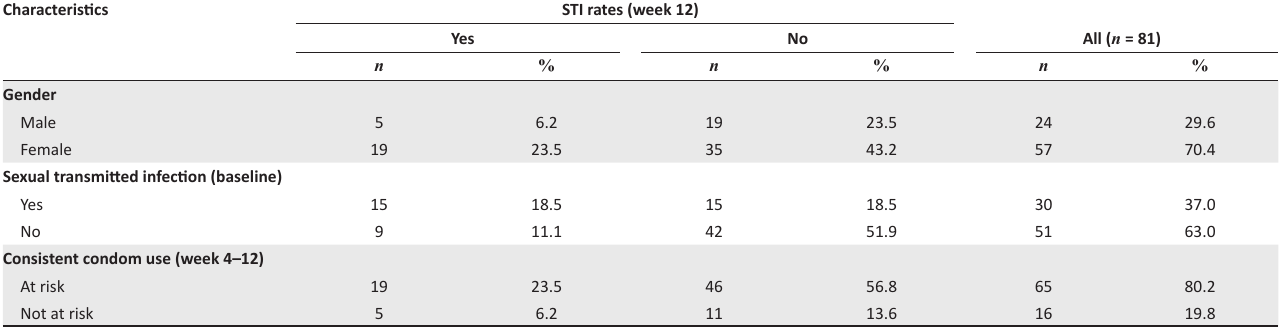
TABLE 3: Sexually transmitted